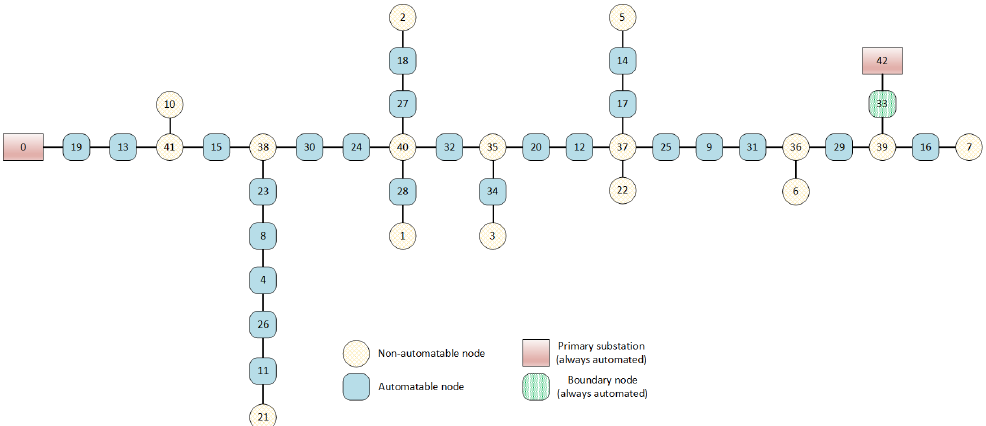
Figure 5. Scheme of the grid adopted for the assessment.